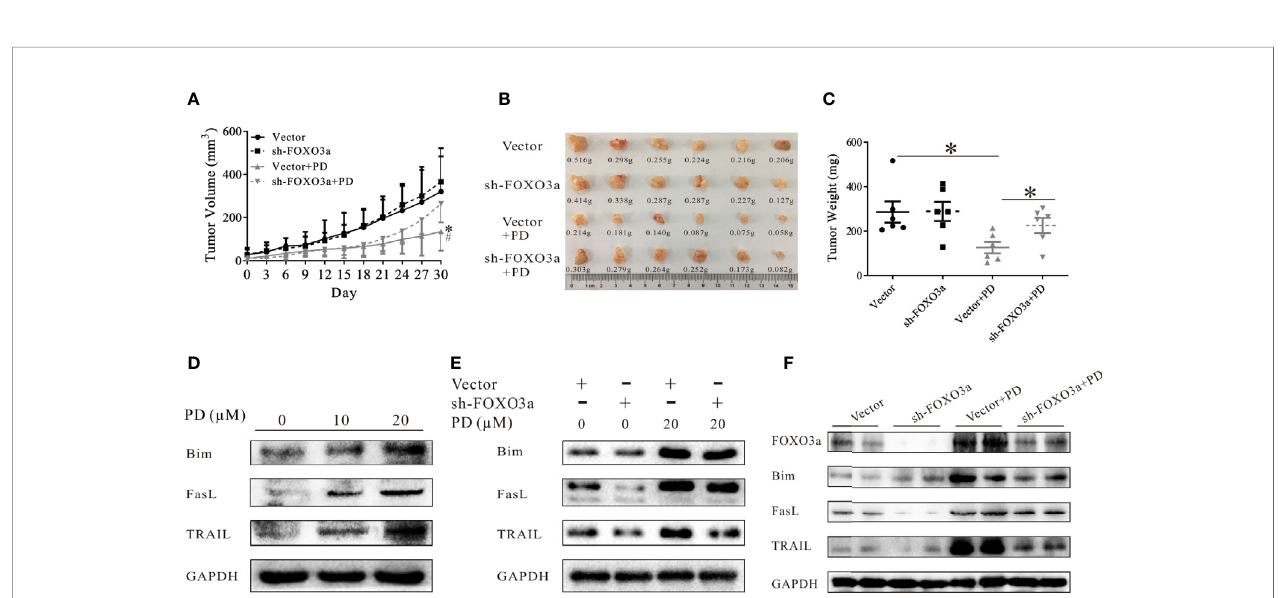
FIGURE 5 | PD regulates the downstream targets of FOXO3a. (A – C) . The effects of PD on the growth of xenograft PC3 tumors after FOXO3a inhibition. (D) . The changes in the expression of FOXO3a target proteins (Bim, Fasl and TRAIL) in PC3 cells were monitored by Western blotting. (E, F) , The effects of PD on FOXO3a target protein expression in vitro (E) and in vivo (F) after FOXO3a inhibition. * p < 0.05.